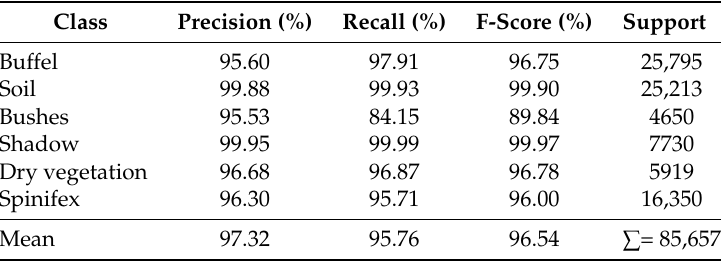
Table 2. Classification report from confusion matrix of Table